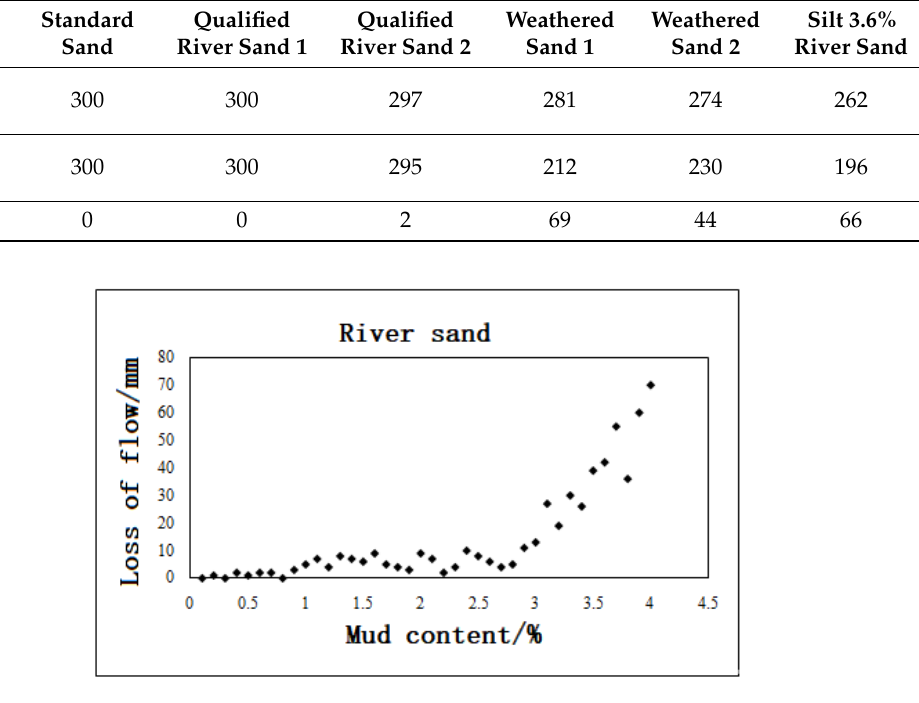
Figure 5. Flow loss of river sand with different silt content.